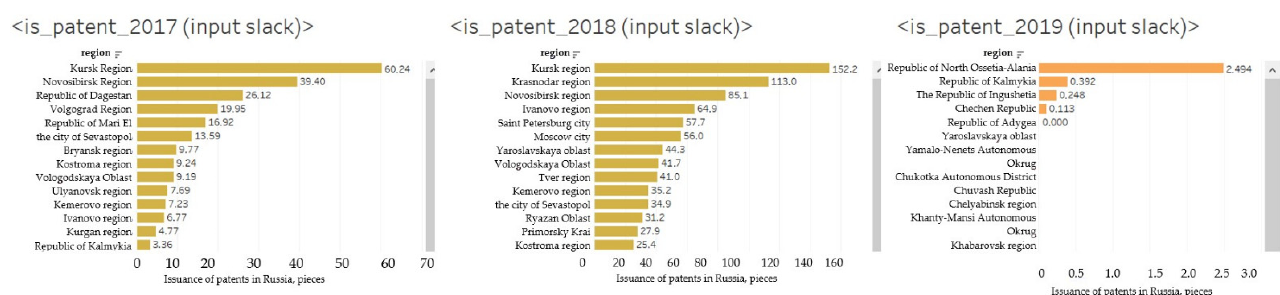
Figure A1. Size of incoming slacks by the indicator insurance of patents in Russia 2017–2019.